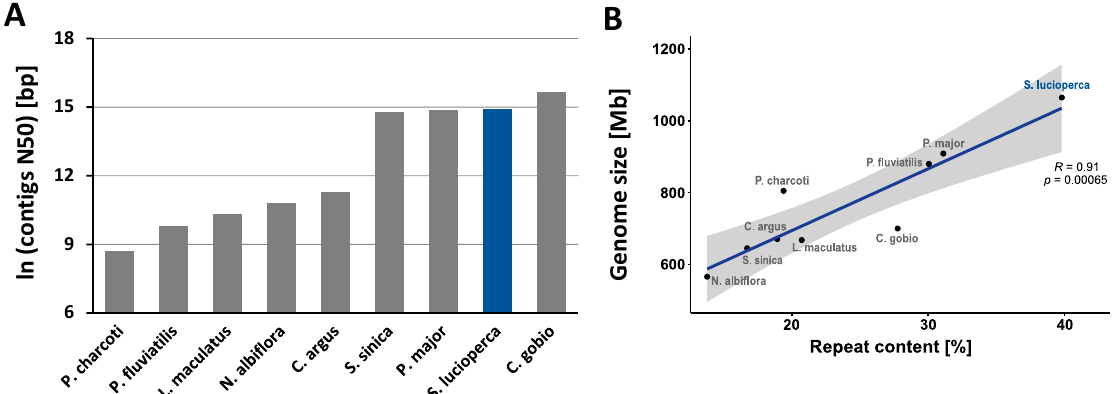
Figure 2. Comparison of contiguity (N50) and repeat content among selected Perciformes fish species. ( A ): Contigs N50 (scaled with natural logarithm) of the pikeperch assembly compared with recently published assemblies of species of the same taxonomic order (Perciformes). ( B ): Correlation of repeat content and genome size in recently published genomes of Perciformes fish species. R is the Pearson’s correlation coefficient and p the associated p -value.